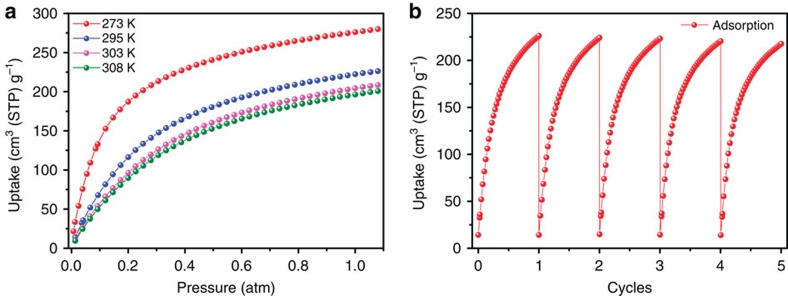
C2H2 adsorption properties.(a) C2H2 adsorption isotherms of FJI-H8 at 273, 295, 303 and 308 K. (b) Cycles of C2H2 adsorption for FJI-H8 at 295 K.